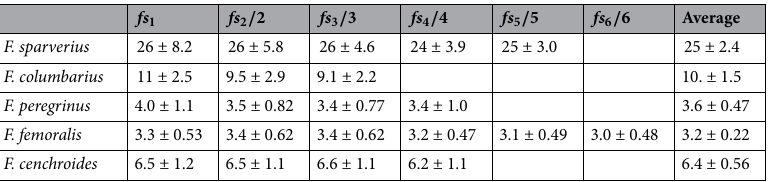
Table 5. The frequency slope per harmonic number fs n / n (in kHz/s) for each species. Errors are 95% confidence intervals.